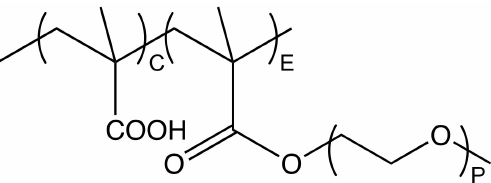
Figure 1. Molecular structure of a comb shaped PCE featuring a methacrylic backbone and PEG side chains with P repeating units. C notes the number of MAA units in the backbone and E refers to the number of side chain bearing backbone